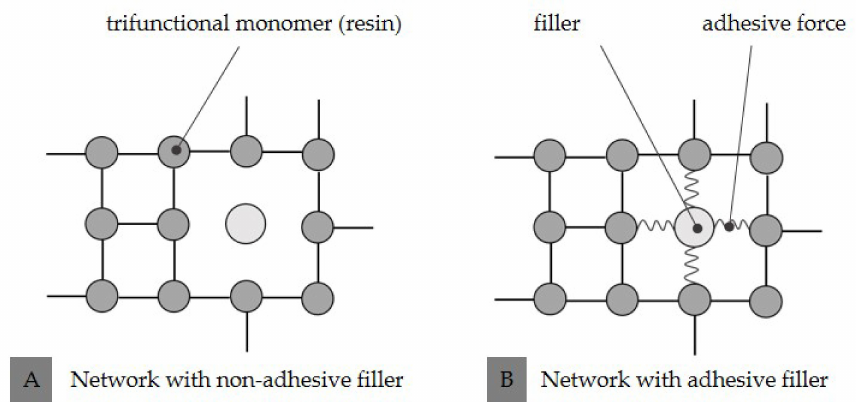
Figure 1. Network structure of filler and resin with no adhesive force ( A ) and adhesive force ( B ) between filler and resin [in parts: